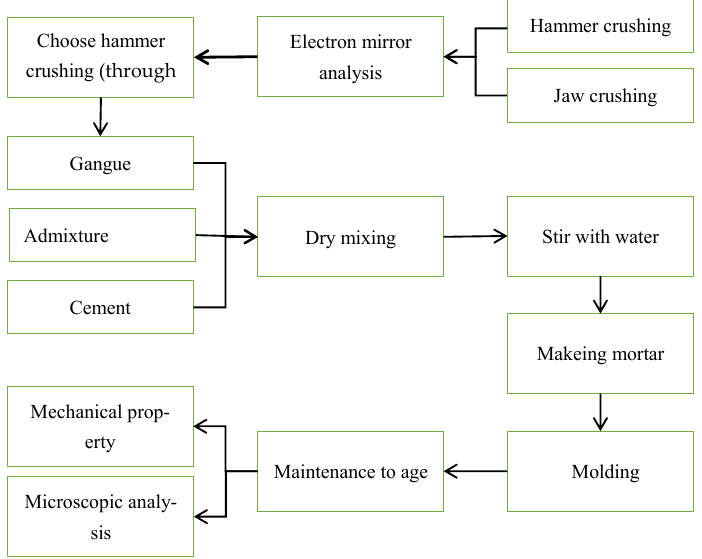
Figure 1. Experimental flow chart.